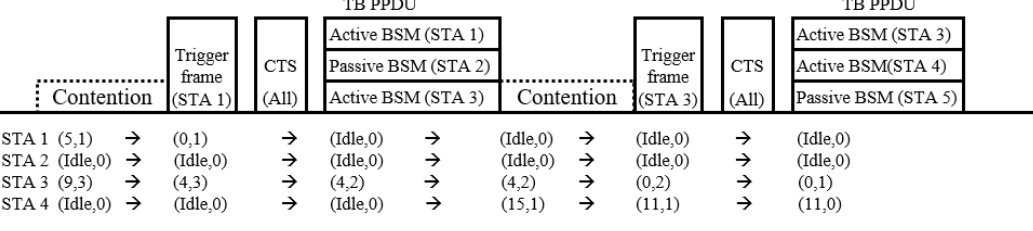
Figure 3. An example of the proposed distributed triggered access